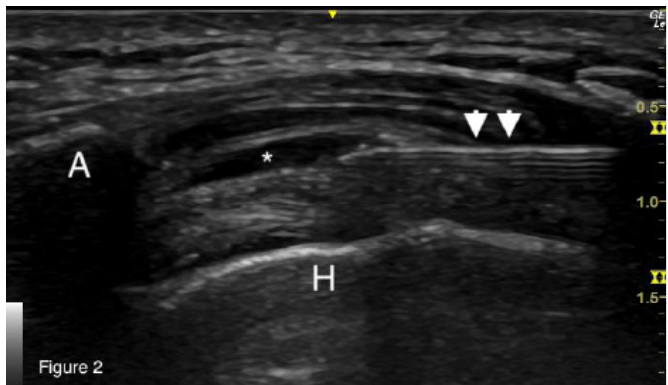
Image 2. Ultrasound still image demonstrating injection into the subacromial/subdeltoid bursa. (A: acromion; H: humeral head; arrowheads: needle; asterisk: subacromial/subdeltoid bursa distended with